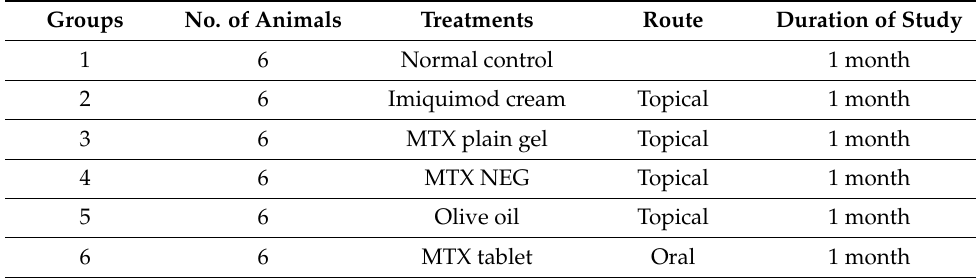
Table 2. Grouping of animals in anti-psoriatic